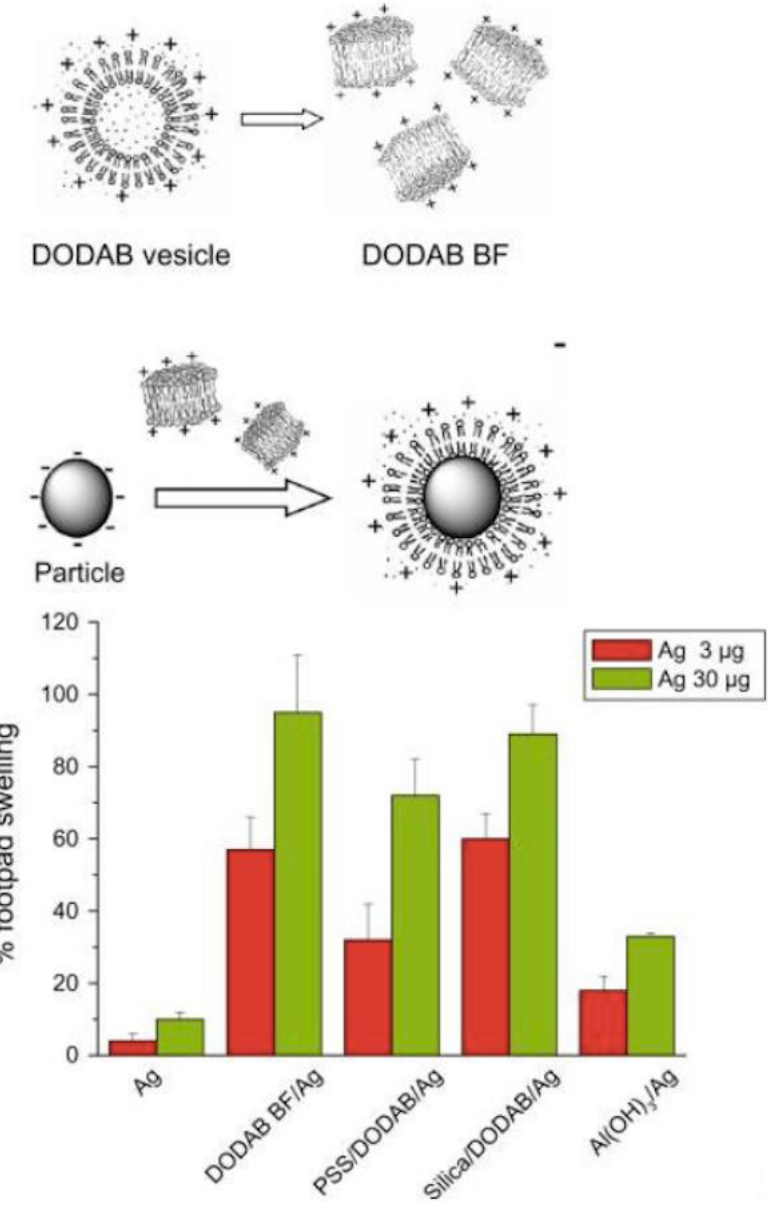
Figure 20. Schematic representation of nanometric dioctadecyldimethylammonium bromide (DODAB)-based adjuvants inducing delayed-type hypersensitivity (DTH) in mice as compared to alum. The same antigen (Ag) carried by each adjuvant was used for immunization. Ag was carried by DODAB BF at 0.1 mM DODAB (DODAB BF/Ag) or by polystyrene sulfate nanoparticles (PSS)/DODAB or by silica/DODAB particles at 0.01 or 0.05 mM DODAB (PSS/DODAB/Ag or silica/DODAB/Ag), respectively, or by alum (Al(OH) 3 /Ag). After immunization, elicitation of the swelling response was done by injecting Ag alone in the mice footpad so that % footpad swelling was measured in comparison to alum [9,10,18]. At the DODAB doses employed, DODAB cytotoxicity was absent against mammalian cells in culture. Adapted from [9,10] with permission from Elsevier, Copyright 2007 and Copyright 2009 and reference [18].